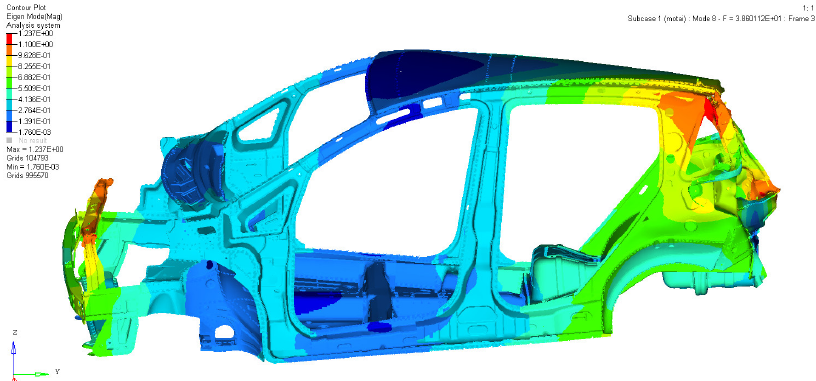
Figure 3. The first-order torsional modal shape of the body-in-white.